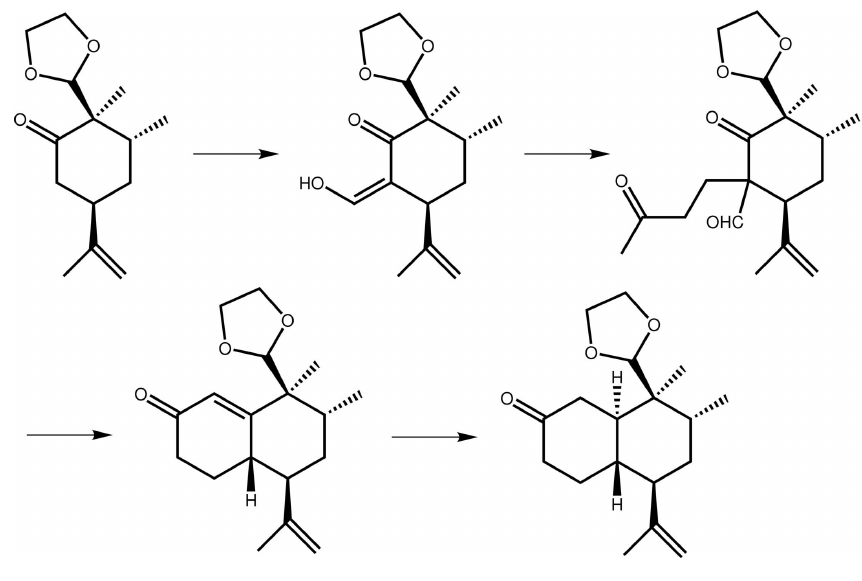
The formation of the title